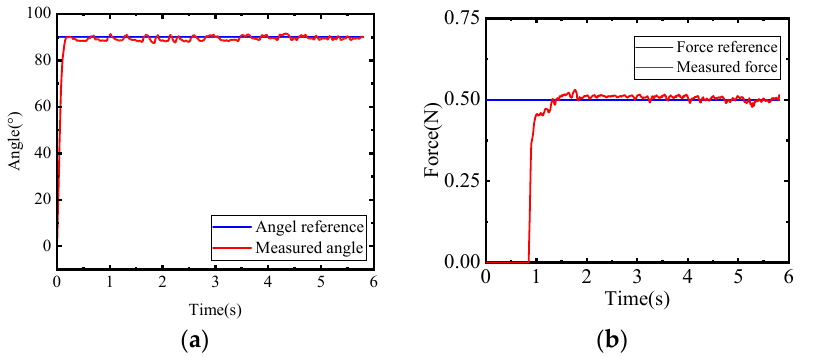
Figure 21. Position and force control experiment results. ( a ) Angle control experiment results ( b ) Force control experiment results.